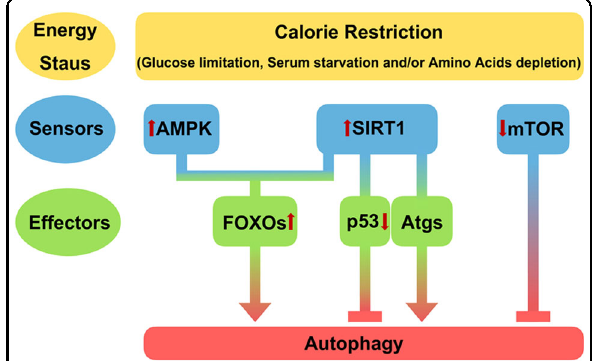
Fig. 1 The regulation of autophagy by SIRT1 under calorie restriction. The level of nutrients (e.g., glucose, lipids, and amino acids) is detected by energy sensors, namely, AMPK, SIRT1, or mTOR 17,97,104 . Calorie restriction activates AMPK or SIRT1 but inhibits mTOR activity. AMPK and SIRT1 upregulate the expression of Atgs through the activation of forkhead box transcription factors (FOXOs) 97,105 . In addition, SIRT1 also forms a molecular complex with Atg proteins, including Atg7 and Atg8 (LC3). SIRT1 deacetylates the core autophagy machinery in nutrient restricted conditions and thereby increases autophagy. Calorie restriction also potentiates the expression of SIRT1 and increases its deacetylase activity 17,18 . SIRT1 deacetylates p53 18 , which downregulates p53 and increases autophagy 19,20 . However, another well-known negative regulator